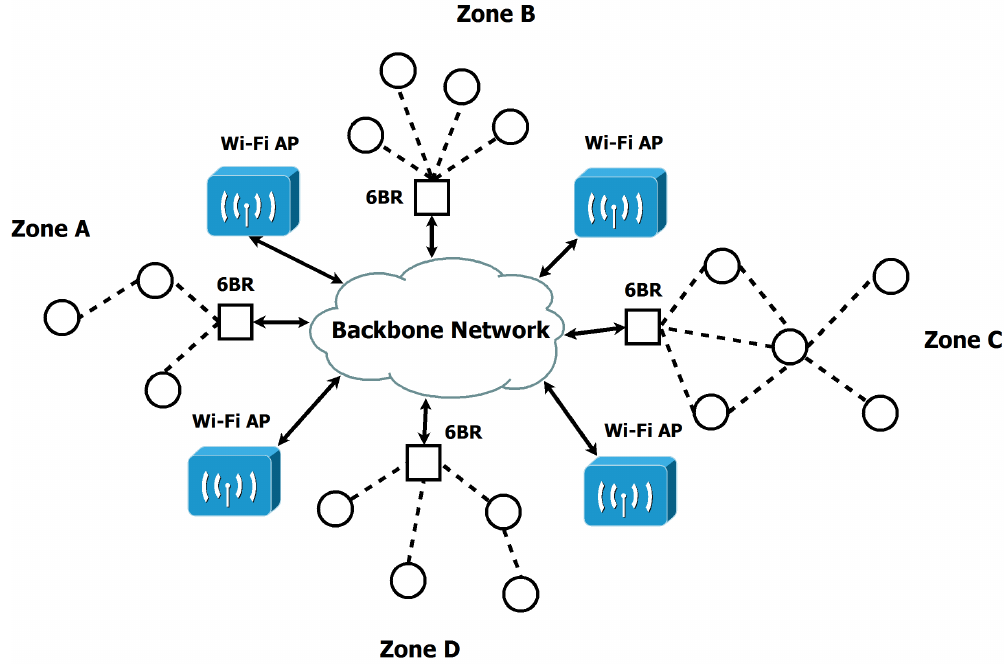
Figure 8. Architecture model of the IoT